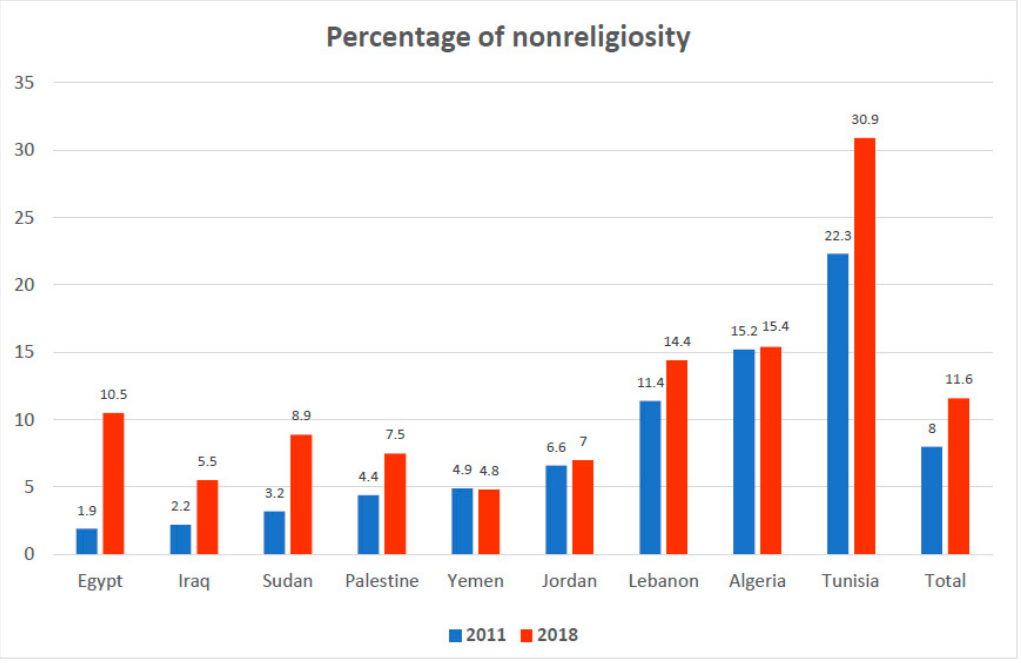
Figure 1. Non-religiosity (Source: Arab Barometer).